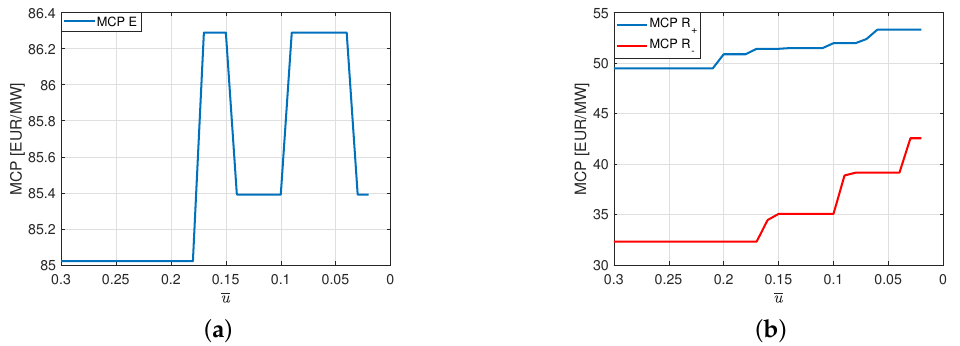
Figure 4. ( a ) Market clearing price ( MCP E ) of the energy sub-market as the parameter u is decreased. ( b ) Market clearing prices of reserve sub-markets ( MCP R + / MCP R − ) as the parameter u is decreased.